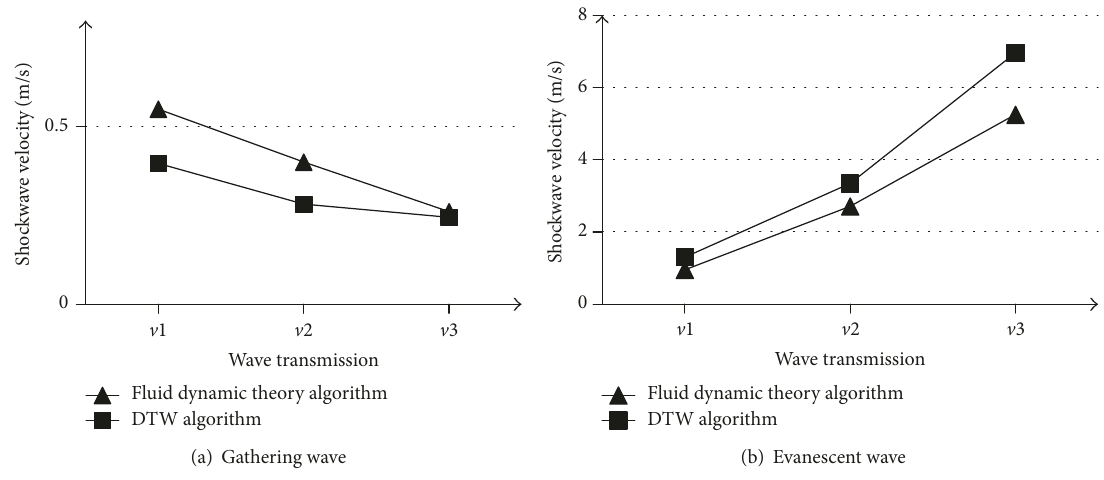
Figure 5: Comparison of the two algorithms for gathering and evanescent wave.